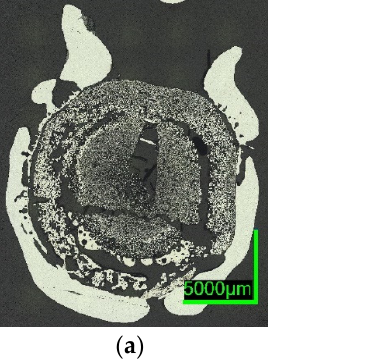
Figure 8. Digital microscope images of ( a ) 0%C-SAF-2; ( b ) 0%C-EAF-2, dipped into EAF/SAF slag.